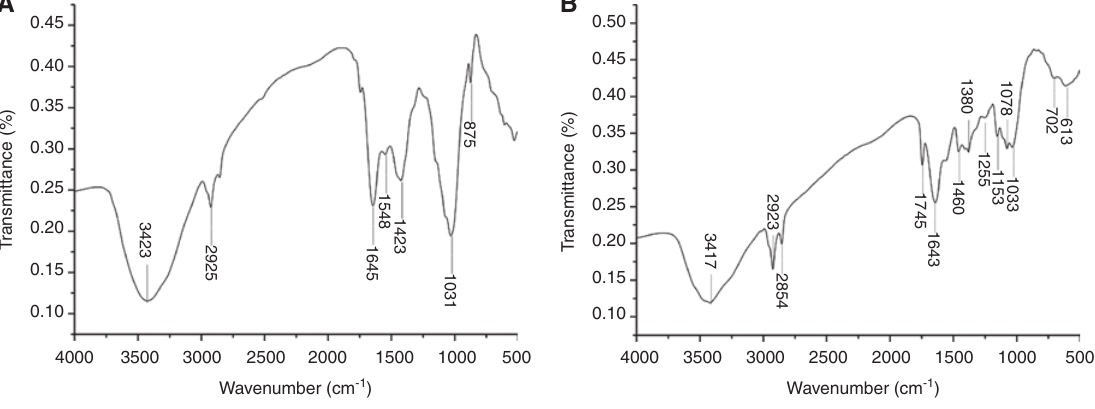
Figure 6: FTIR spectra of (A) control and (B) metal-loaded biomass. Spectra of fungal biomass identifying different functional groups on the surface of fungus. The dried biomass was prepared with potassium bromide pellet technique and then analyzed with the range of scan wave from 400 to 4000 cm -1 with Thermo Nicolet 6700, FTIR